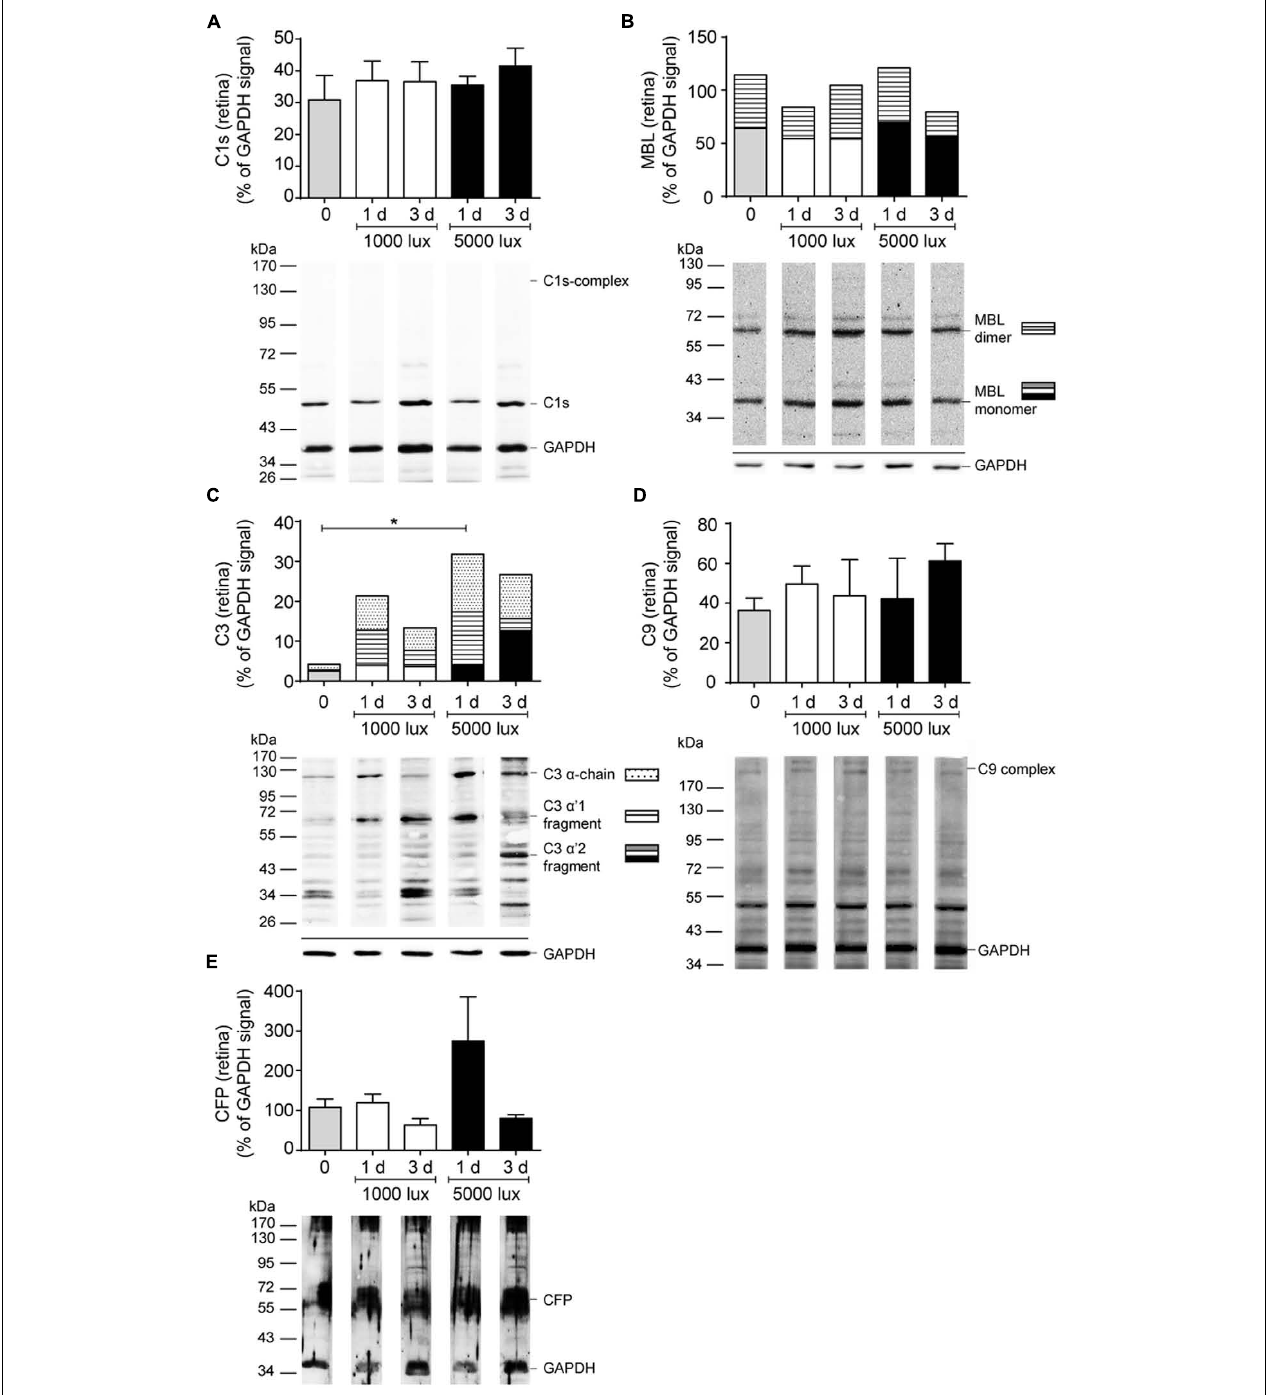
FIGURE 4 | Complement protein expression in the retina showed increased C3 deposition after LD. Complement protein expression of (A) C1s (see also Supplementary Figure S6A), (B) MBL (see also Supplementary Figure S6C), (C) C3 (see also Supplementary Figure S6D), (D) C9 (see also Supplementary Figure S6B) and (E) CFP (see also Supplementary Figure S6E) in the retinae of mice either treated with constant (1000 lux, 24 h; white bars) or acute white light (5000 lux, 0.5 h; black bars) was compared to untreated controls (gray bars) in Western blot. (B,C) Stacked bars correspond to different molecular weights of protein fragments. Data represent mean percentages of the GAPDH control signal of 4–6 mice of each treatment group. Exemplarily Western blots are shown for complement protein detection in one mouse tissue, respectively (for entire blots see Supplementary Figure S6). Blots were sequentially developed (Supplementary Figure S4). CFB and C4 were not detected in retinae. ∗ 0.01 < P < 0.05 (ordinary one-way ANOVA, Dunnett’s multiple comparisons test, with a single pooled